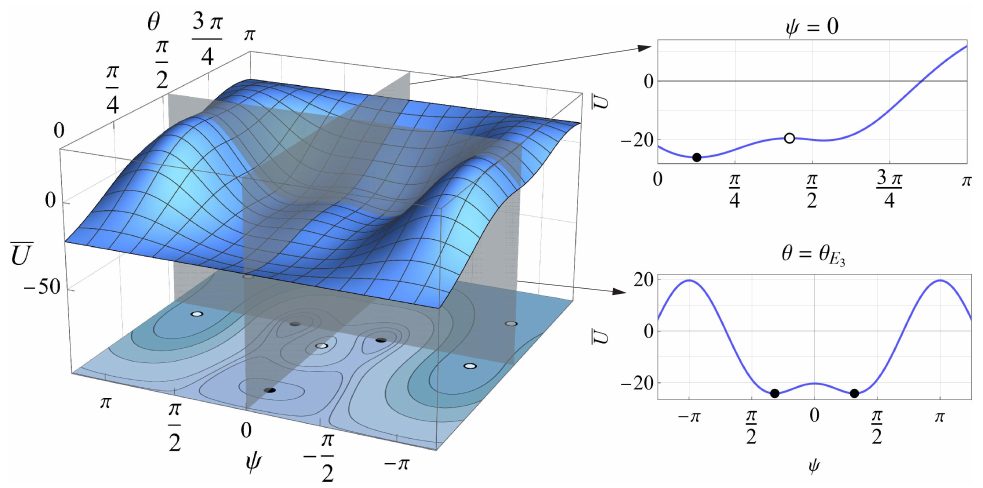
Figure 6. Dimensionless dynamic potential in LEO ( h = 700 km, β = 20). Black dots: stable equilibrium; white dots: unstable equilibrium.